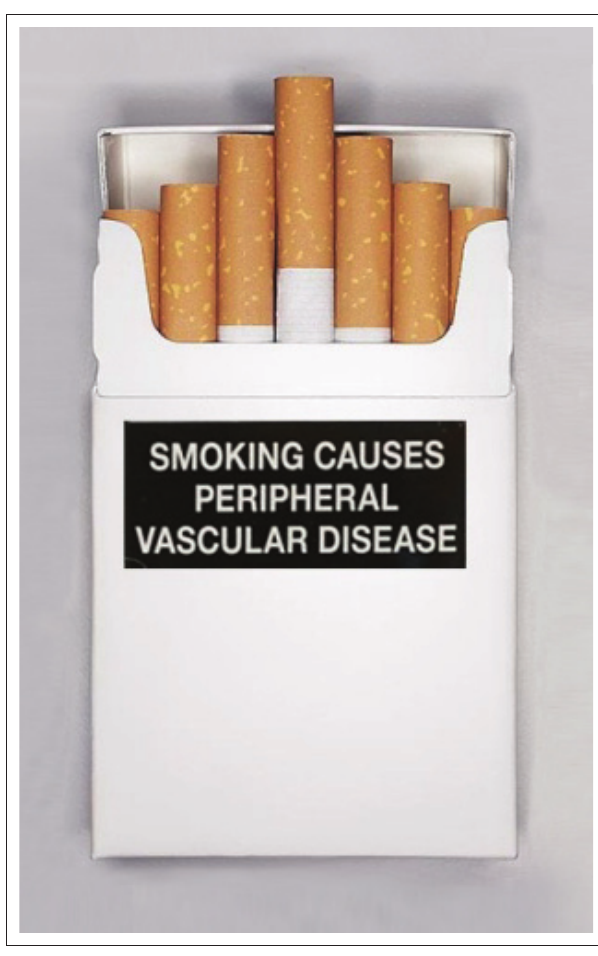
FIGURE 1: Text-based warning: Smoking causes peripheral vascular